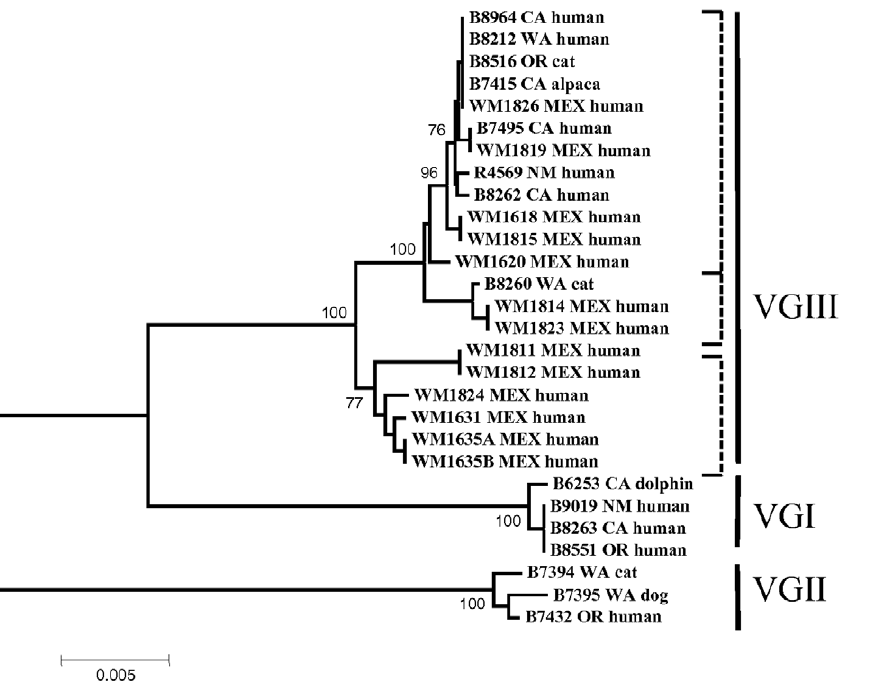
Figure 3. Neighbor joining dendrogram showing genotype VGIII isolates from the Pacific Nothwest of the US, California and Mexico. The isolate from New Mexico is more closely related to isolates from California, Washington and Oregon than to most of the isolates from Mexico, possibly indicating a US enriched clade of C. gattii VGIII. Significant bootstrap values are shown.